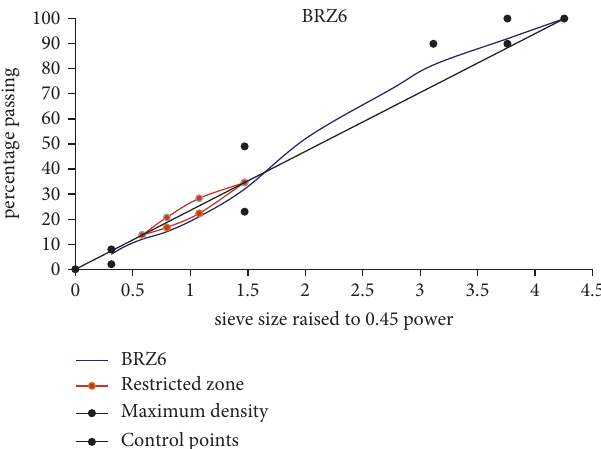
Figure 5: Superpave gradation using 0.45 power chart for 6% CSD fller.